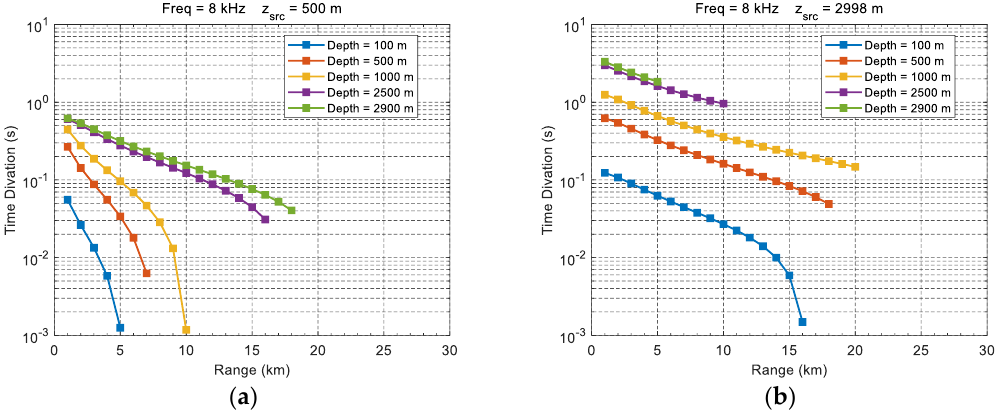
Figure 8. Propagation time deviation between the reflected signal and the direct signal. ( a , b ) Propagation time deviation of the base station at depths of 500 m and 2998 m, respectively. Blue, orange, yellow, purple, and green colors denote user depths of 100 m, 500 m, 1000 m, 2500 m, and 2900 m, respectively.